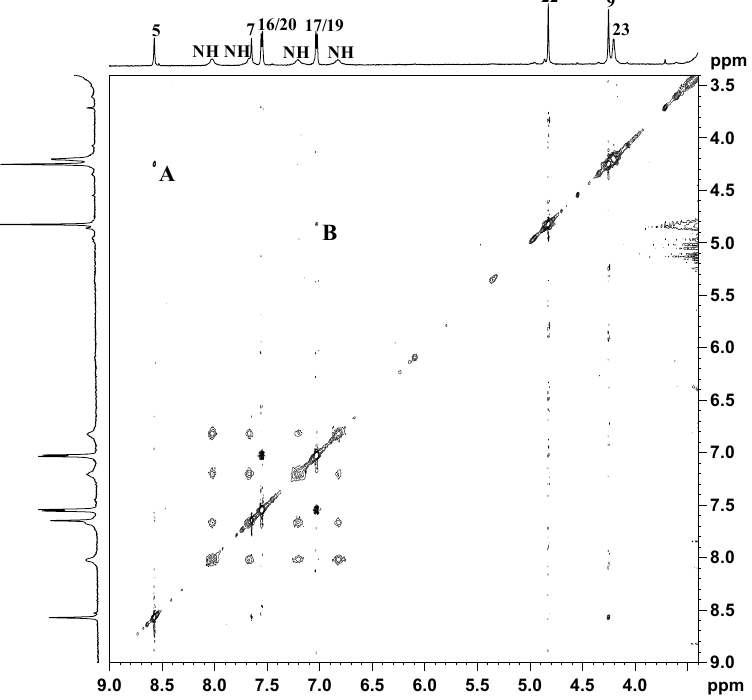
Figure 5. Portion of 1 H ( top and left ) and NOESY 2D ( center ) NMR spectra (600 MHz, 1 H) of 3 in DMSO- d 6 .